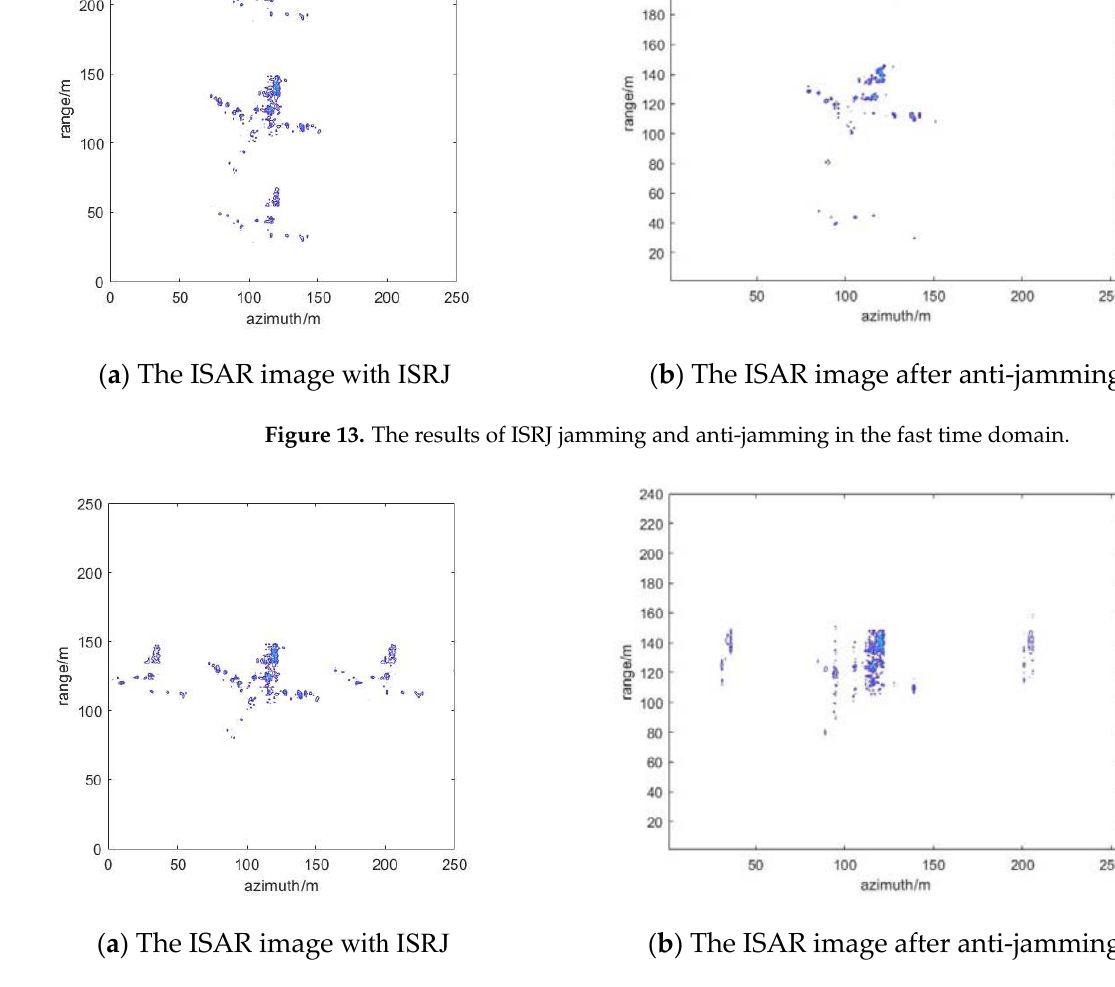
Figure 14. The results of ISRJ jamming and anti ‐ jamming in the slow time domain.